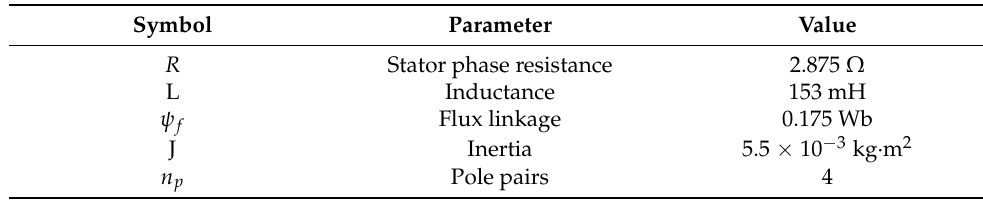
Figure 3. Comparison between traditional SMC and STRL-SMC for disturbance suppression. Table 1. Parameters of